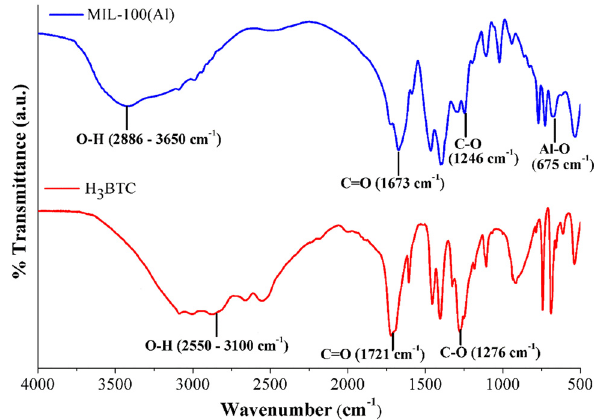
Figure 3: FTIR spectra of the synthesized MIL - 100 ( Al ) and H 3 BTC ligand.